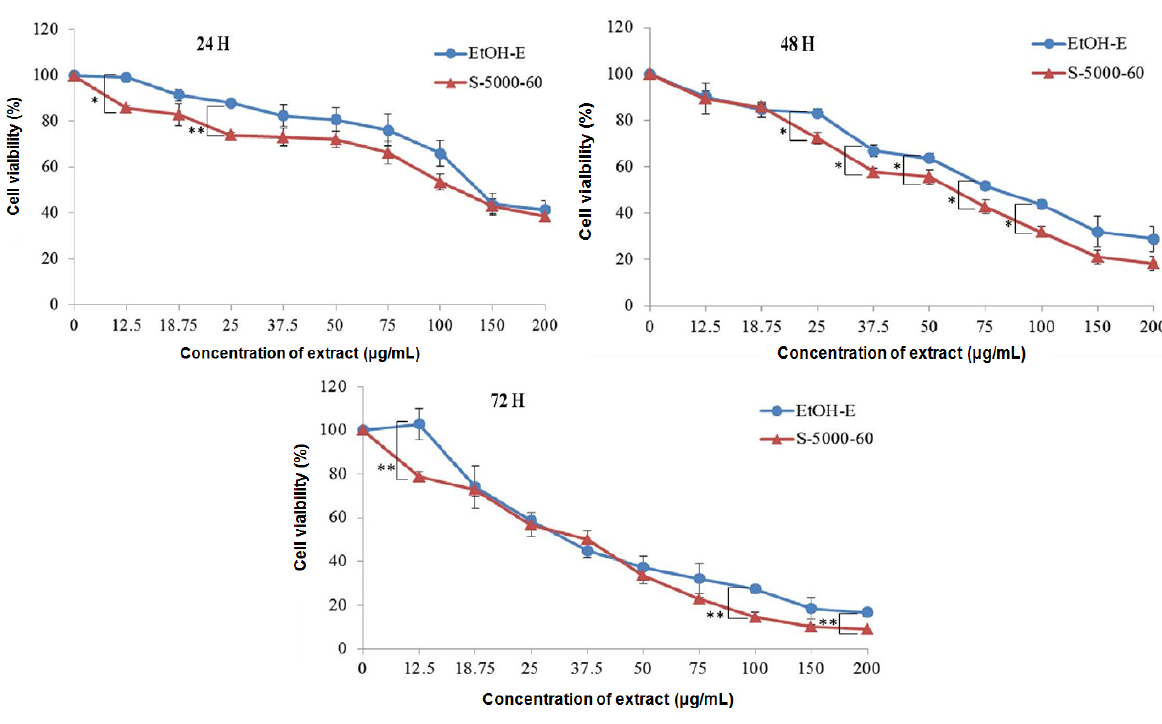
Figure 4. Effects of S-5000-60 and EtOH-E extracts on hepatocellular carcinoma (HepG2) cells proliferation at 24, 48 and 72 h treatment, respectively. Cells were treated with varying concentrations of S-5000-60 and EtOH-E. The growth inhibition rate of HepG2 cells was assessed by 3-(4,5-dimethylthiazol-2-yl)-2,5-diphenyltetrazolium bromide assay. * p < 0.05 vs. Control; ** p <